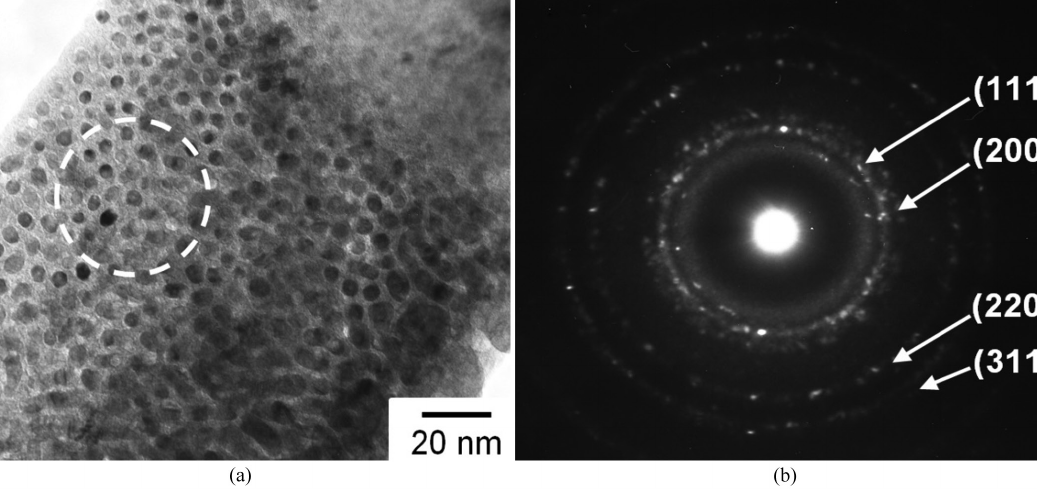
Cu Zr ribbon. (a) BF image and (b) the corresponding SADP of a circle area in 60 20 20